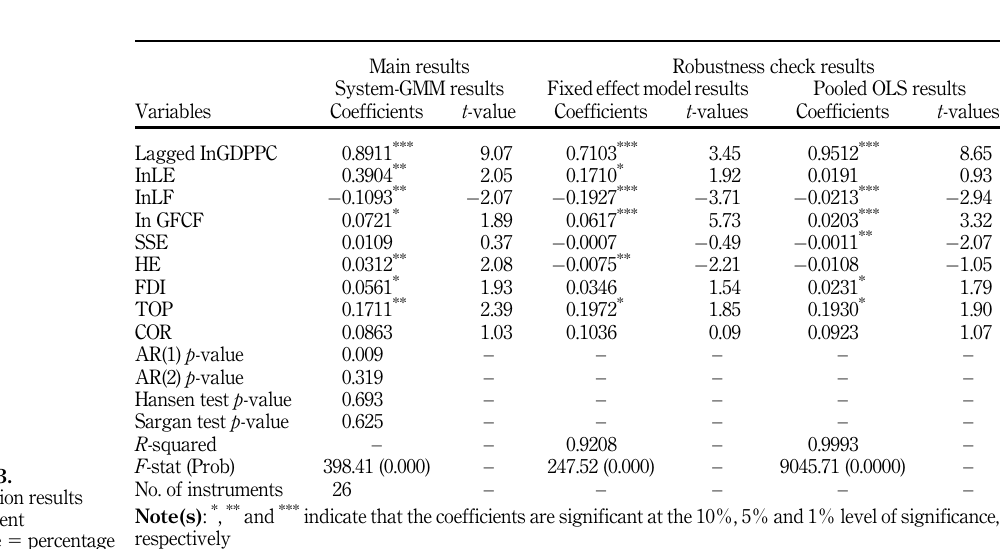
Table 2. Correlation coefficient